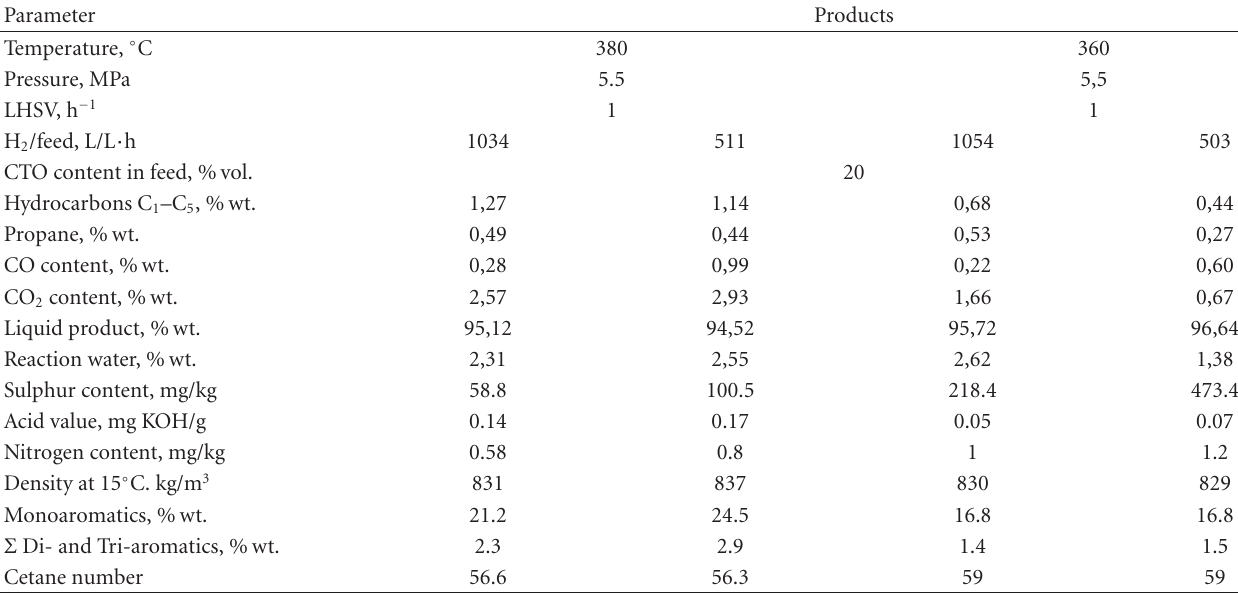
Table 6: Results of hydrorefining of the mixtures of gas oil and crude tall oil; catalyst C.